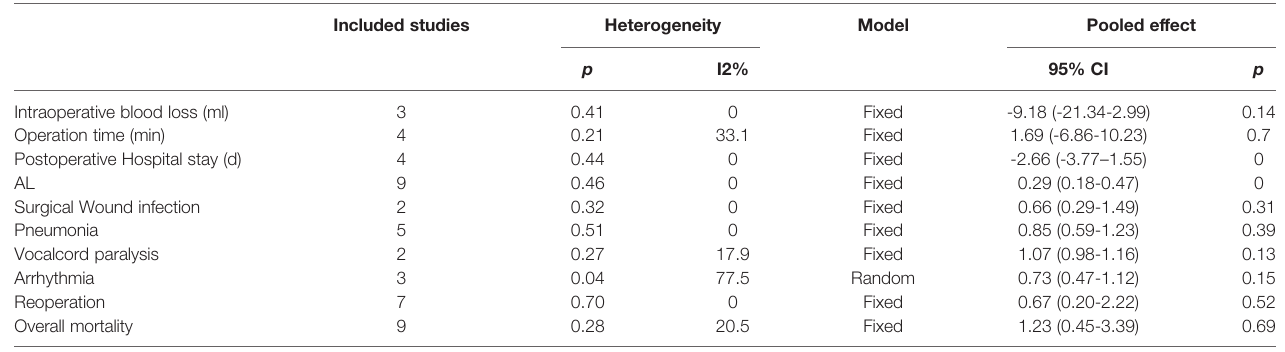
TABLE 3 | Summary of short-term clinical